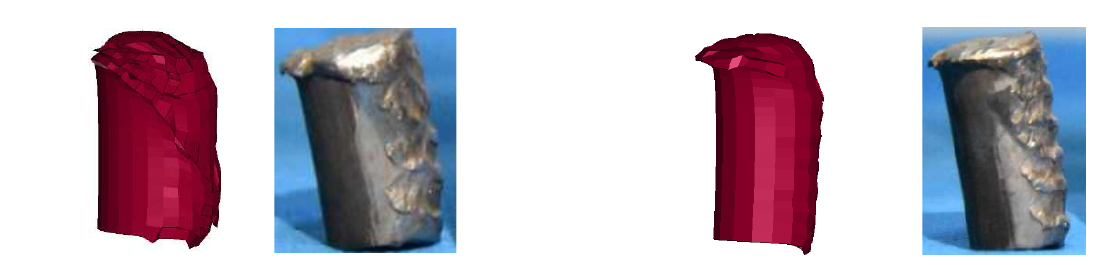
Figure 7. Comparison of projectile failure morphology between the test and numerical simulation.